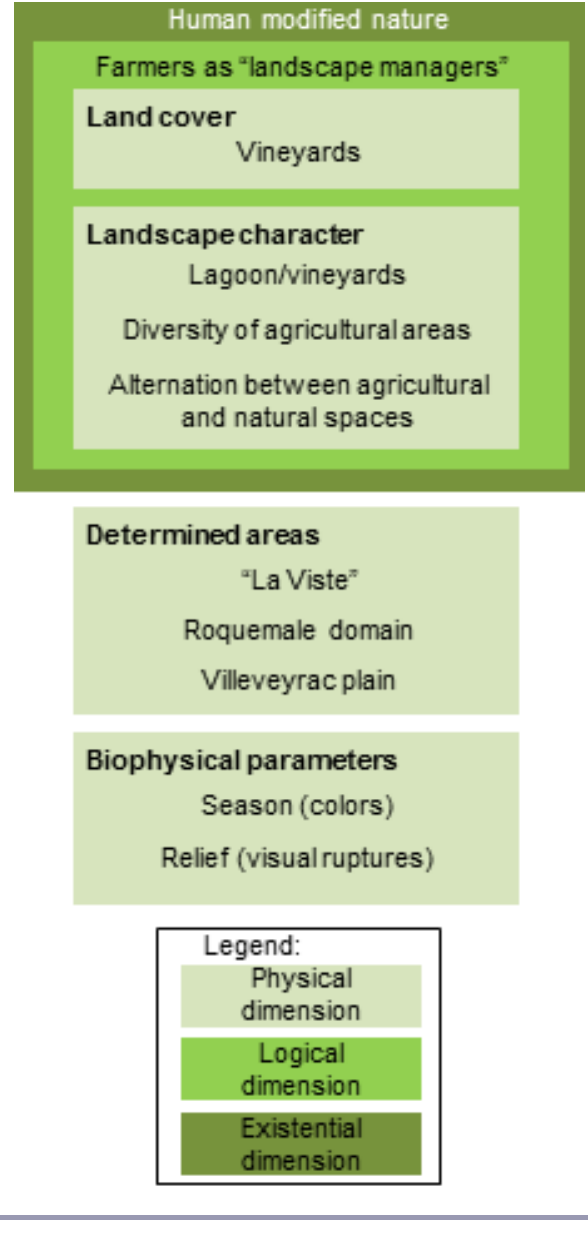
Fig. 5 . The aesthetic landscape service in Thau lagoon. Different physical, logical, and existential elements interact to generate the aesthetic landscape